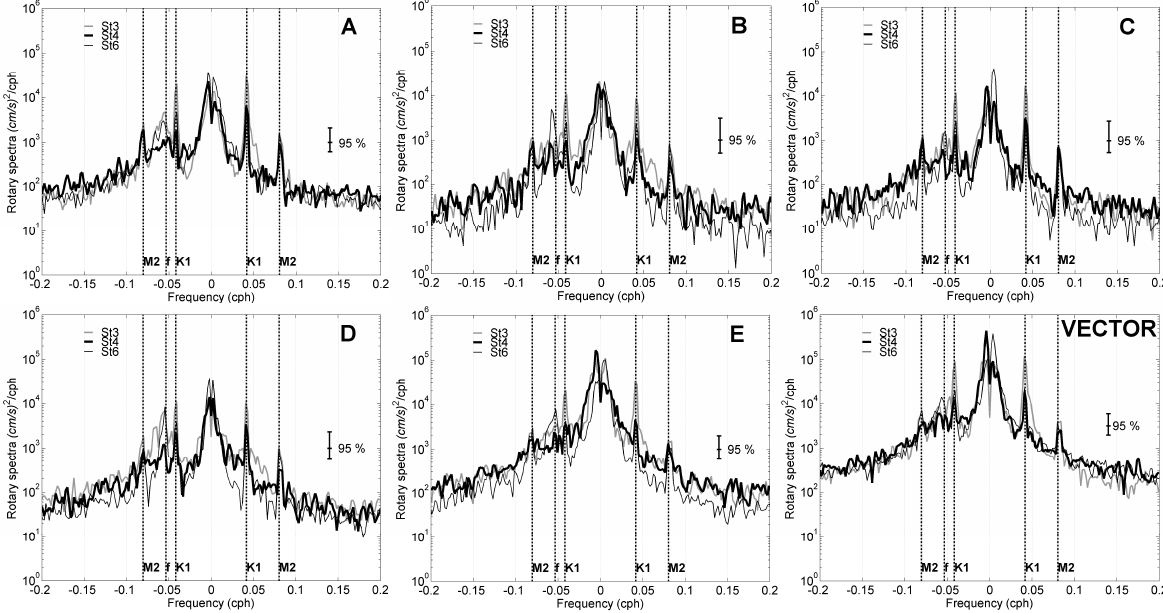
Fig. 7. Rotary spectra for the deepest ADCP cell during five MATER periods (A, B, C, D and E) and VECTOR. Inertial ( f ) and principal tidal frequencies (M2 and K1) are indicated by dashed lines. f is the Coriolis parameter divided by 2 π .